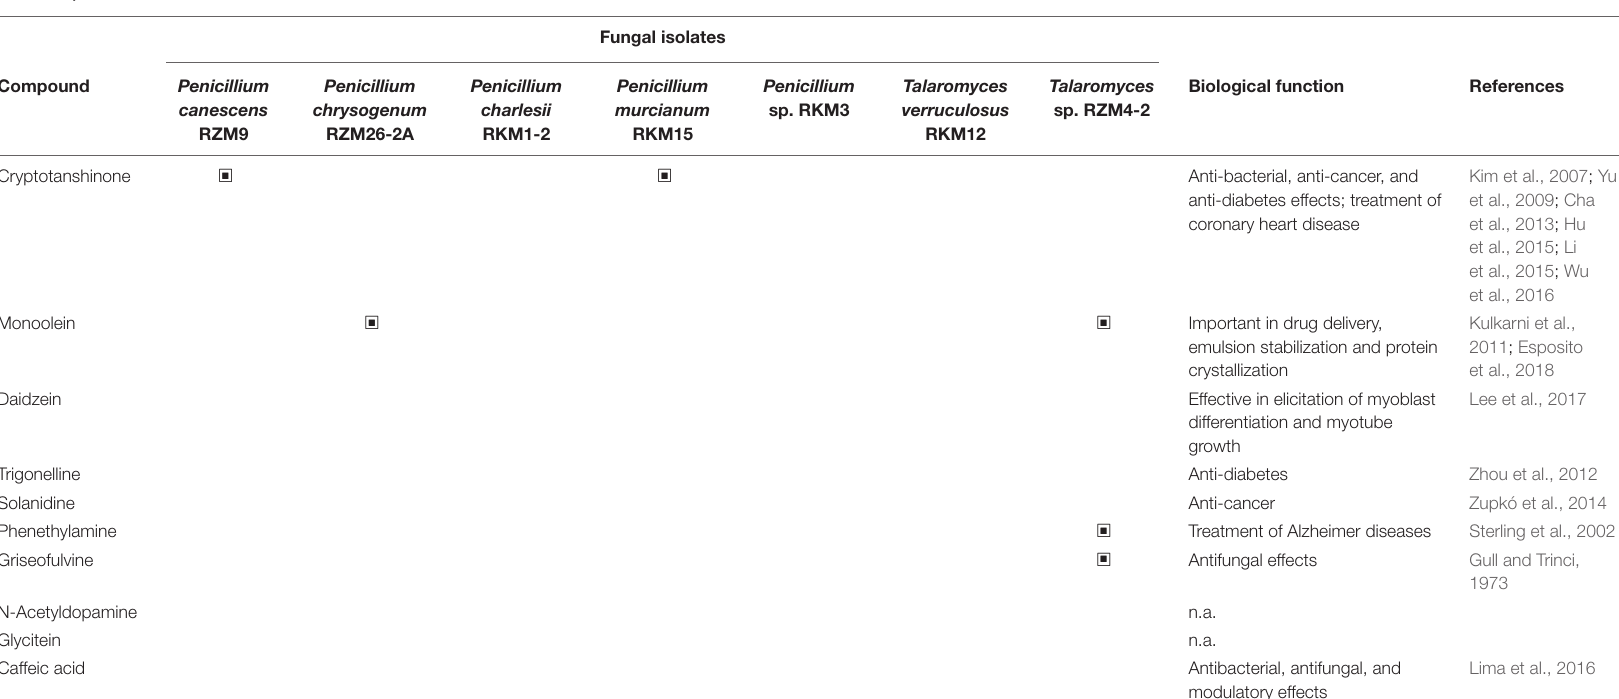
Squares indicate the excretion of specific compounds by distinct isolates. Biological functions were derived from available